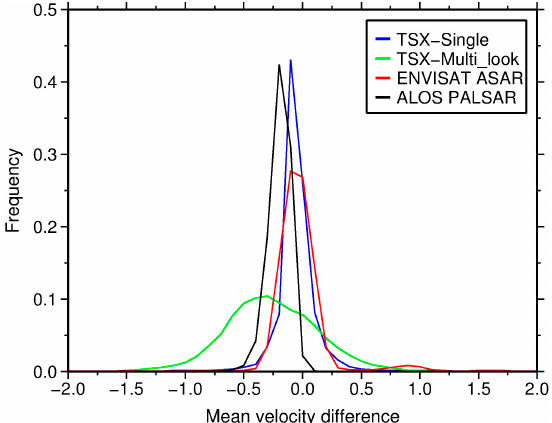
Figure 11. Histograms of the mean deformation rate difference caused by external DEM difference and geocoding multi-look operations for three platforms. The blue line represents the histogram of mean deformation rate difference between single-look geocoding with TanDEM-X DEM and single-look geocoding with SRTM-1arc DEM. The green line is the result between single-look geocoding with TanDEM-X DEM and multi-look geocoding with SRTM-1arc DEM. Red and black solid lines represent the results of ENVISAT ASAR and ALOS/PALSAR images with single-look geocoding operation, respectively.